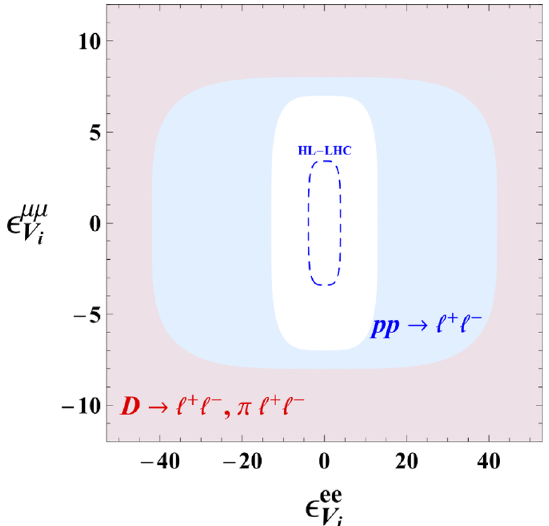
Figure 4 . Exclusion limits at 95% CL on c → u‘ + ‘ − transitions in the ( (cid:15) ee i = LL, RR, LR, RL . The region outside the red contour is excluded by D meson decays, while the region outside the blue contour is excluded by high- p T